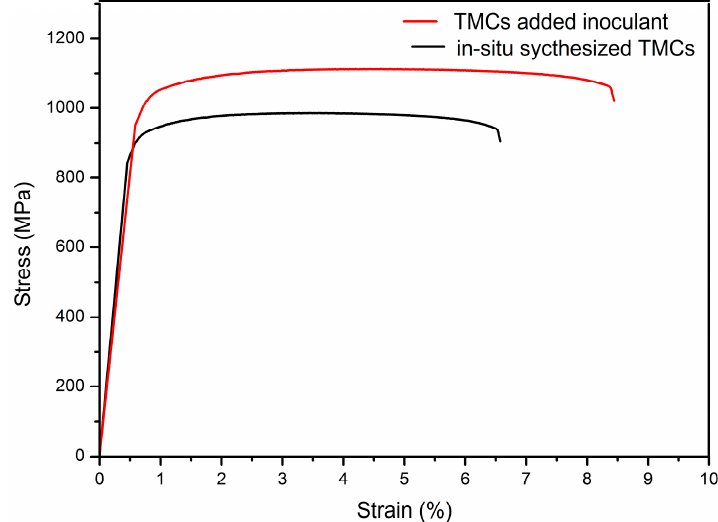
Figure 11. The stress-strain curves of TMCs modified and reinforced with 0.6 wt % inoculants and reinforcement prepared by different methods.